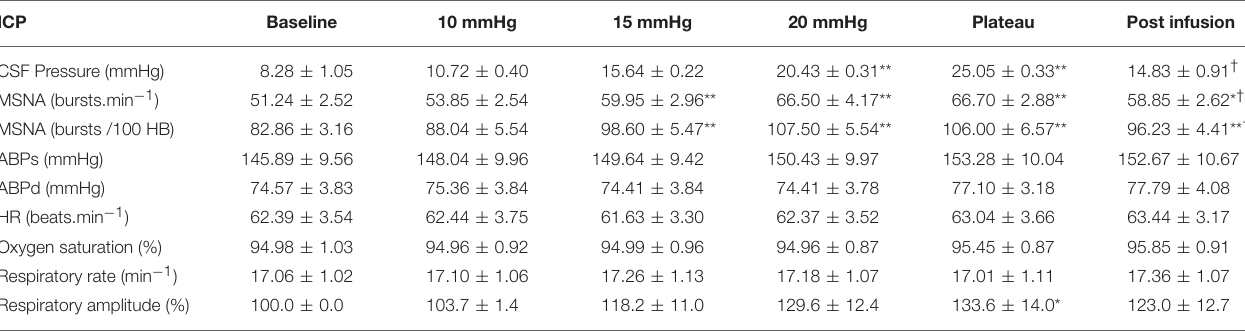
TABLE 3 | Results of sympathetic activity and systemic parameters during modest ICP increase and decrease in human ( n = 10). ICP